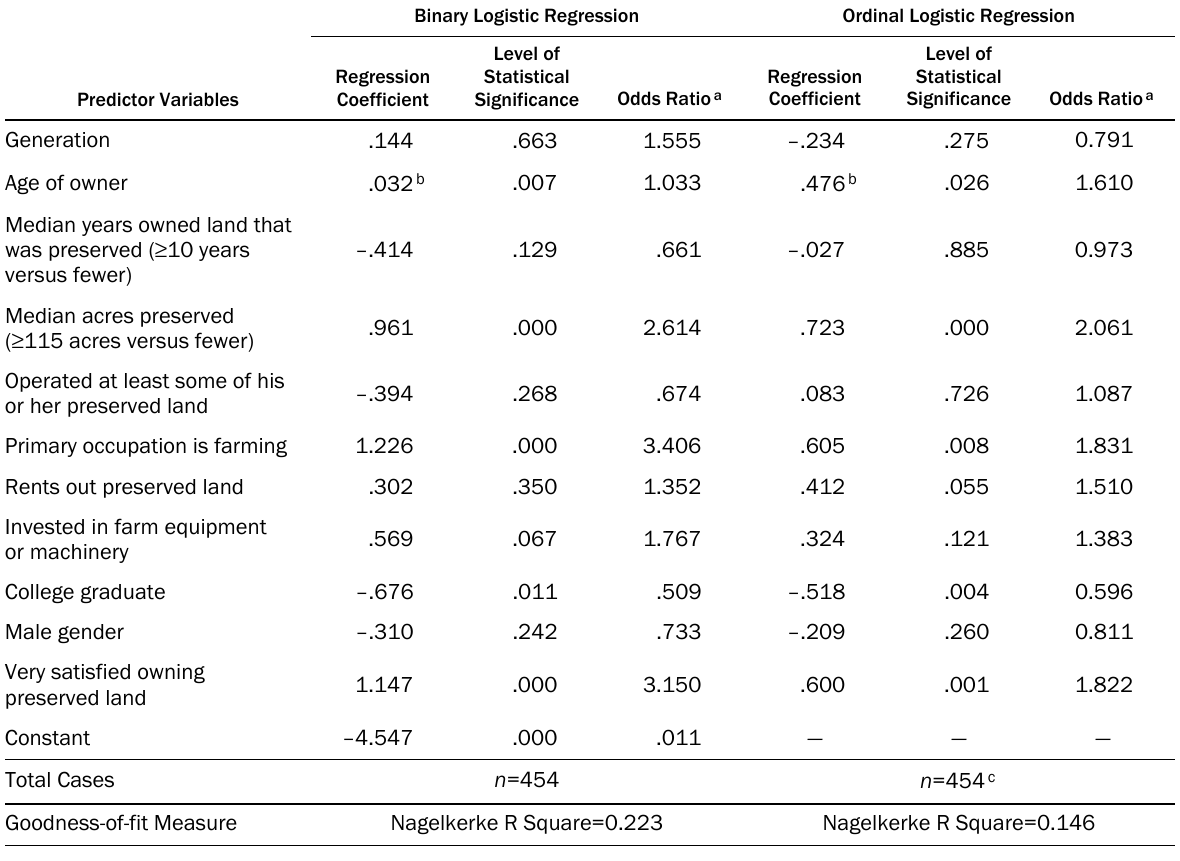
Table A2. Results of Logistic Regression Analysis: Predictors of a Respondent Having a Successor Who Will Use Preserved Land for Agricultural